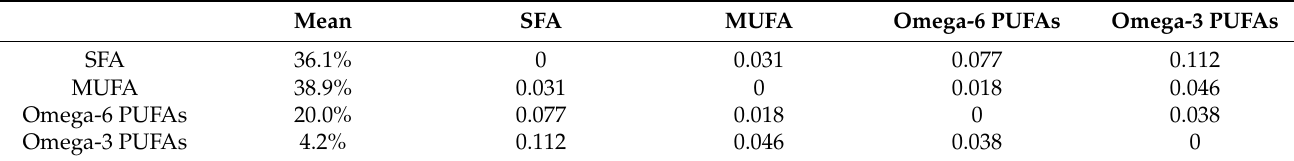
Table 2. Compositional geometric means and variation matrix of fatty acids